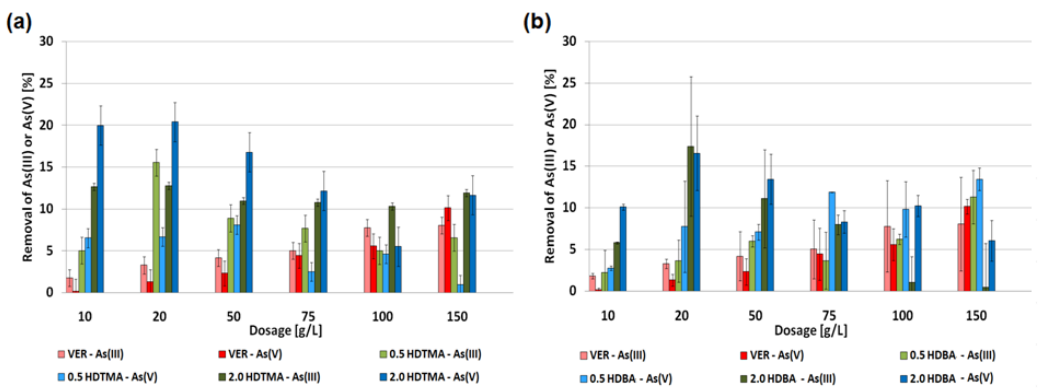
Figure 9. Sorption of As(III) or As(V) ions as a function of equilibrium concentration for ( a ) VER, 0.5 HDTMA, 1.0 HDTMA, and 2.0 HDTMA, and ( b ) VER, 0.5 HDBA, 1.0 HDBA, and 2.0 HDBA.